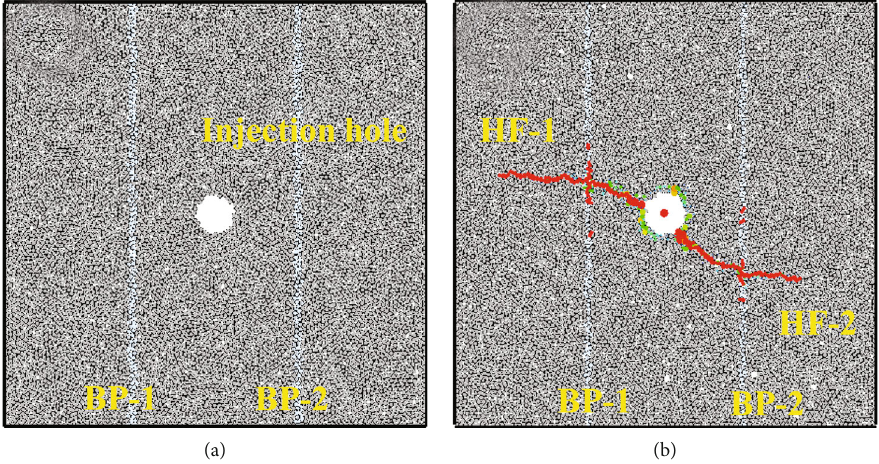
Figure 12: Group 2-1 hydraulic fracture test: (a) test block before hydraulic fracturing; (b) test block after hydraulic